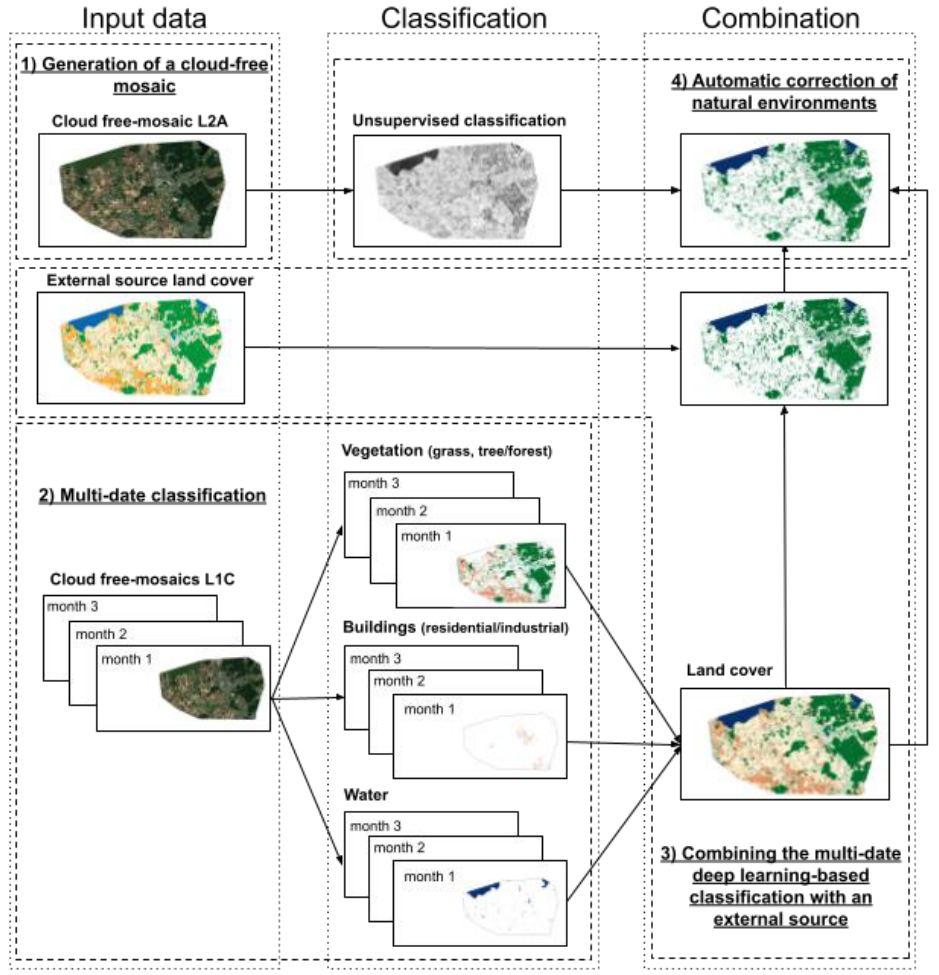
Figure 1: The proposed workflow to improve land-cover segmentation.